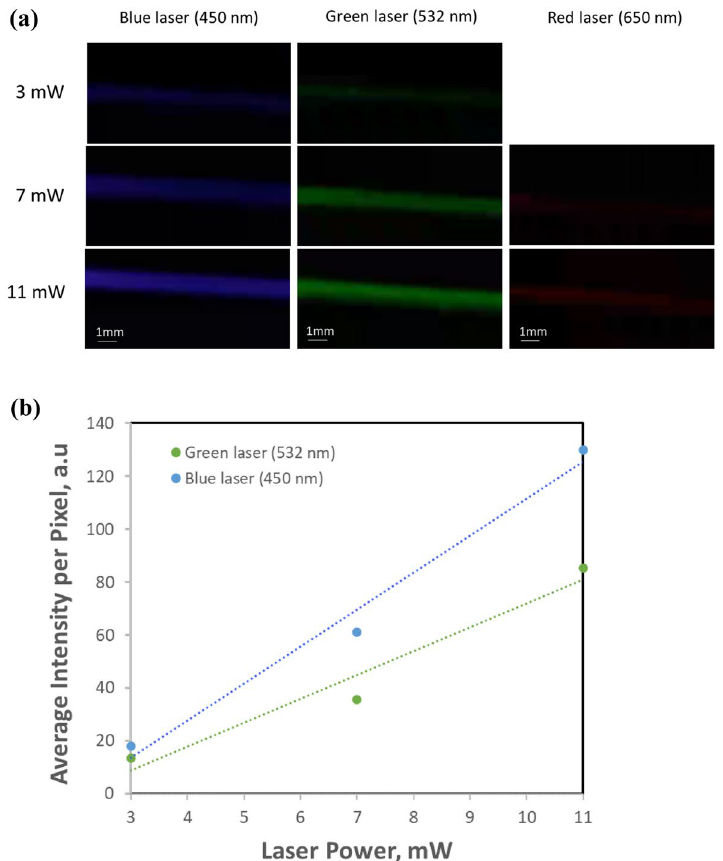
Figure 2. Light scattering images of pure water and the effect of laser power. ( a ) Light scattering images using lasers of nominal laser wavelengths at different laser powers. ( b ) The average intensity per pixel extracted from light scattering images using blue (450 nm) and green (532 nm) lasers at different laser powers. The water is purified, filled, and sealed into a clean glass bottle in a semiconductor fabrication clean room, and